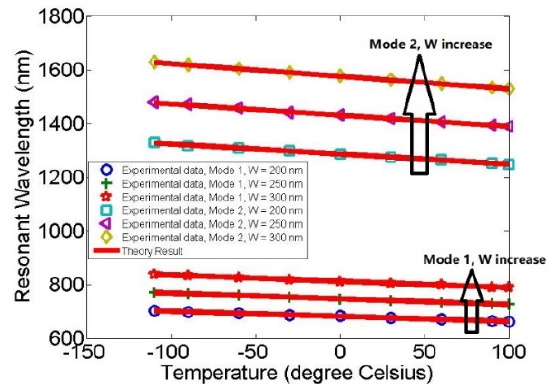
Figure 7. The wavelength at the resonant peak as the function of the temperature for different structural parameters, W. The blue circle, green plus, and red asterisk correspond with W = 200 nm, W = 250 nm, and W = 300 nm, respectively, in mode 1; the cyan square, purple triangle, and yellow diamond correspond with W = 200 nm, W = 250 nm, and W = 300 nm, respectively, in mode 2. The experimental data were calculated by the finite element method and the theoretical result was used further validated by MATLAB, corresponding to the red solid line.